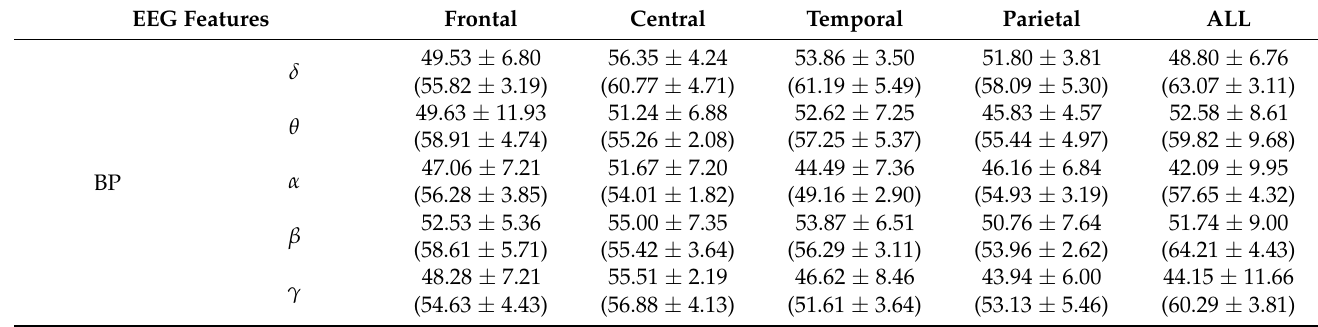
Figure 4. Topoplots of 5-fold CV classification accuracies in BP, coherence (COH), HFD, and KFD features. The accuracy distribution shown around the occipital area should be ignored, because the EEGs from O1, O2, and Oz were not analyzed in the present study. Table 4. Comparison of 5-fold cross validation accuracies among different features, frequency bands, and scalp regions using LDA (in %). In each grid of this table, the numbers inside and outside the brackets denote the accuracies obtained from the features with and without the SBS-based feature